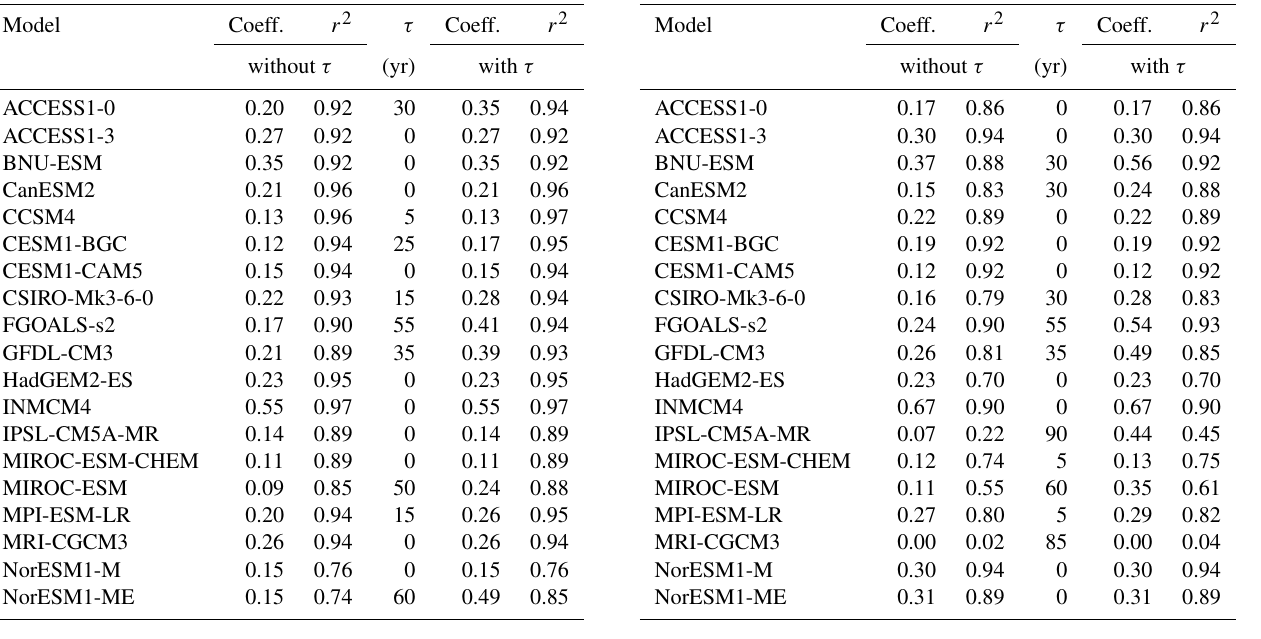
Table 4. Amundsen Sea sector: scaling coefficients, α r , and time delay, τ r , between increases in global mean temperature and sub- surface ocean temperature anomalies.